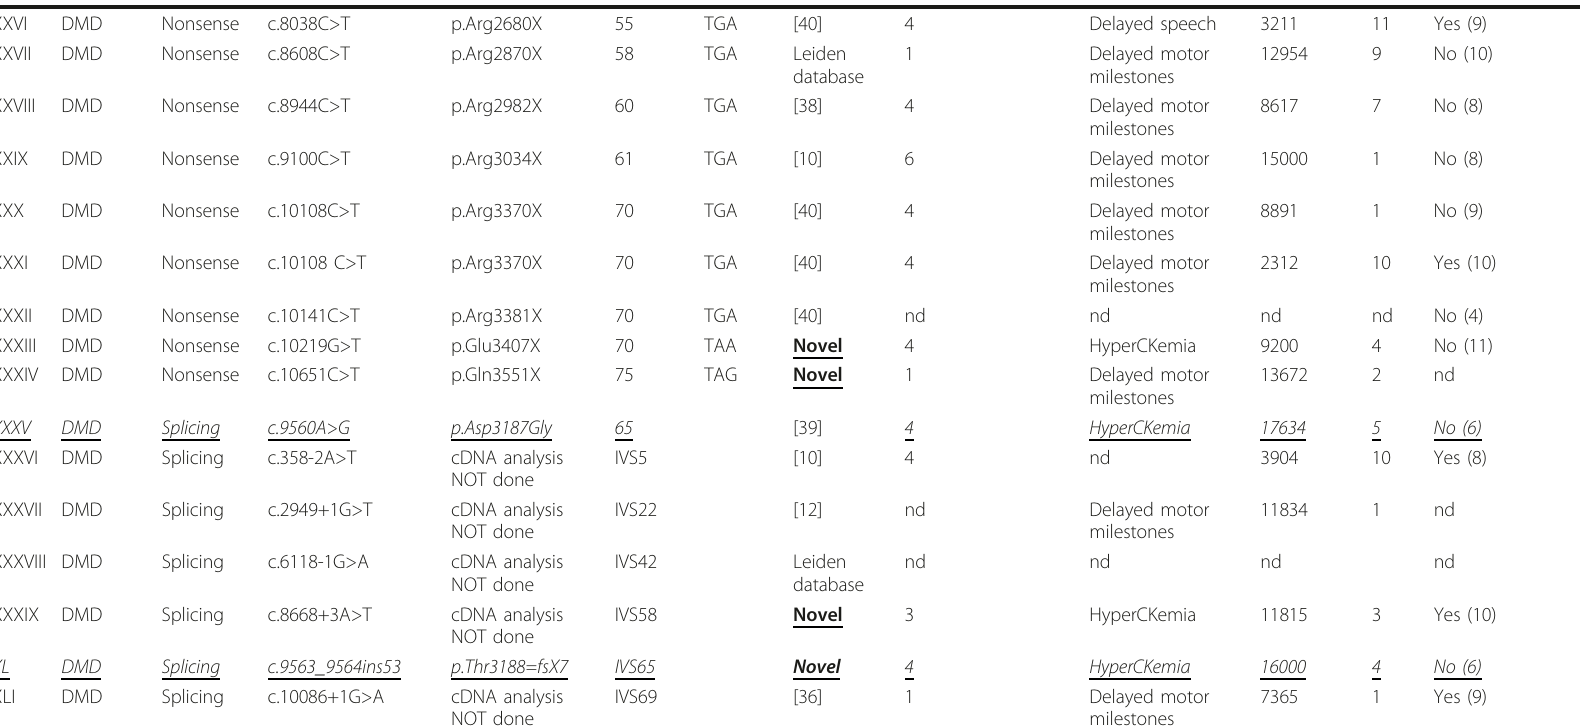
Table 1 Clinical and molecular characteristics of patients carrying point mutations in DMD gene